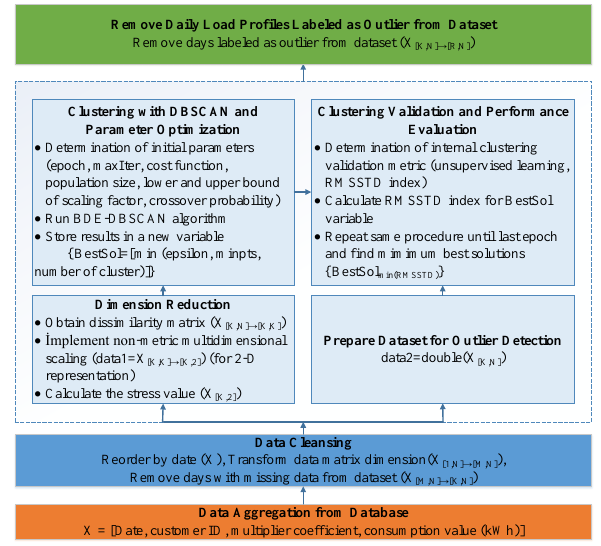
Figure 1. Modelling framework of the proposed outlier